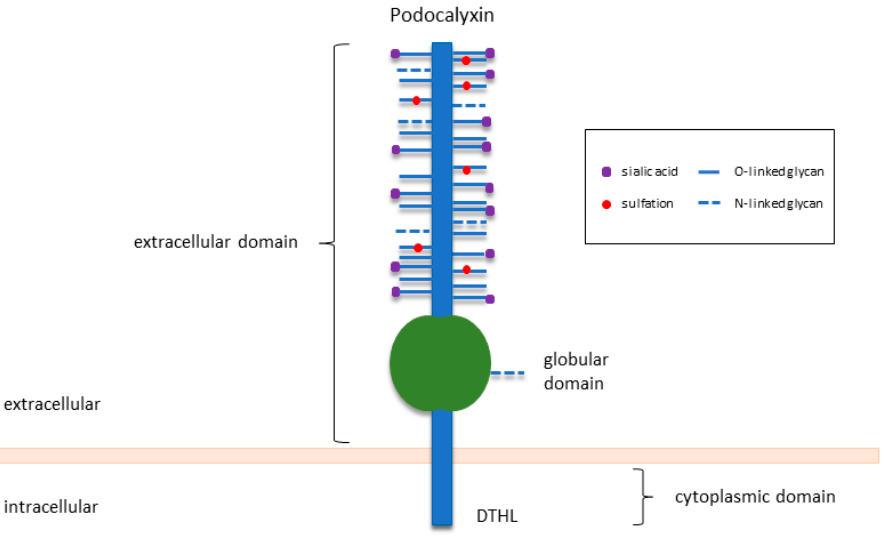
Figure 1. Structure of PODXL. Adapted from McNagny and Hughes [20].